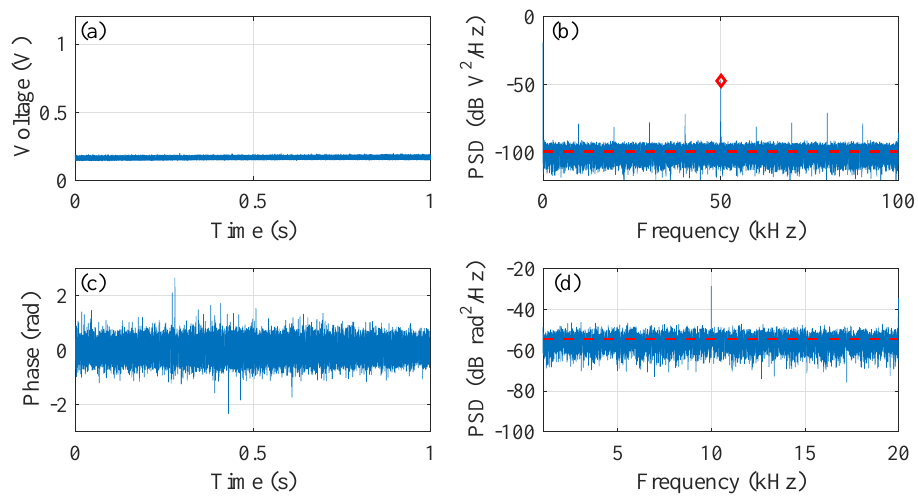
Figure 5. Results for channel 314 (high noise channel). ( a ) the detected intensity signal; ( b ) the PSD of the intensity signal; ( c ) the demodulated phase signal; ( d ) the PSD of the phase signal.